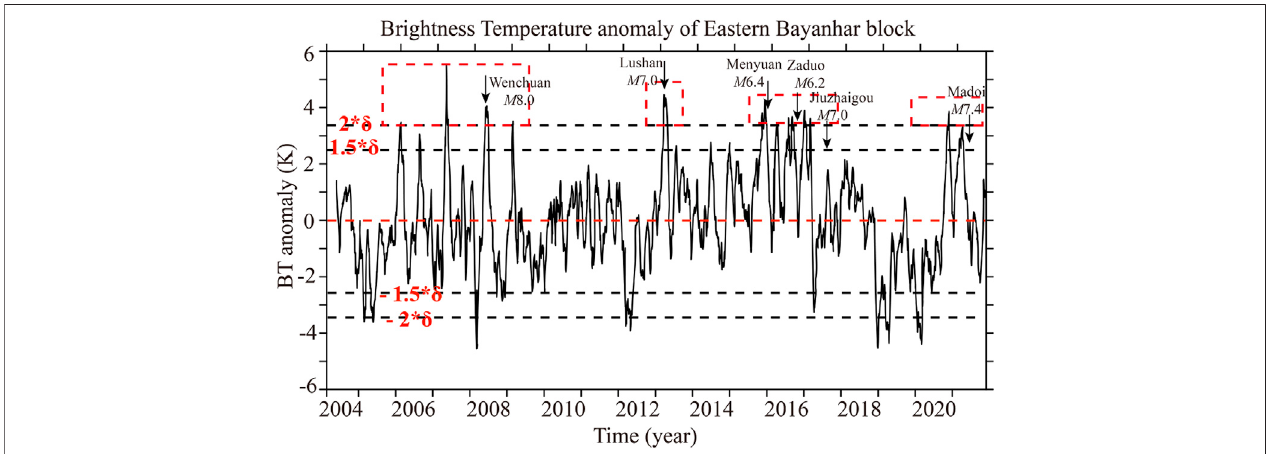
FIGURE 9 | Time series of BT anomaly of the Eastern Bayanhar block from 2004 to